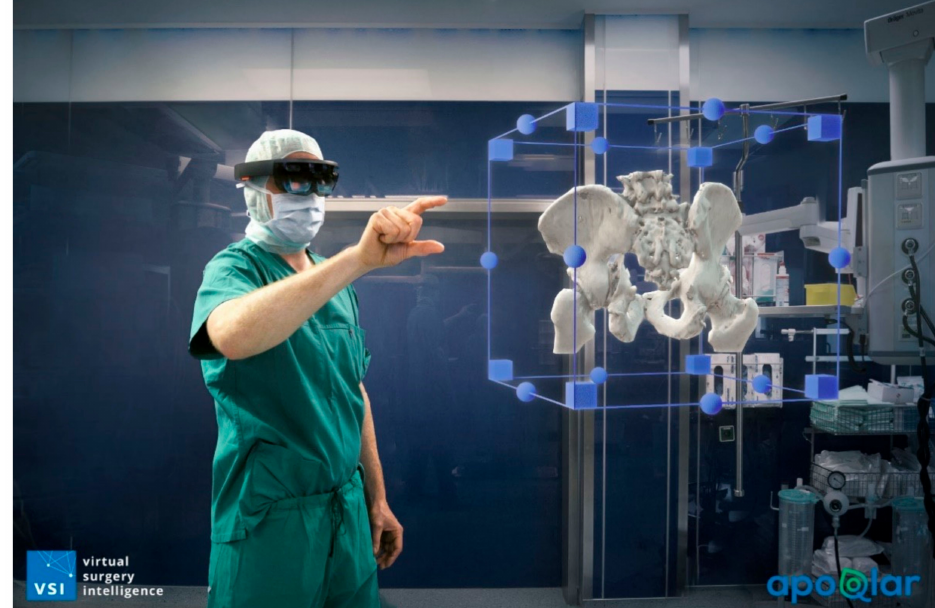
Figure 1. The image indicates how the operator can visualize a part of the patient’s anatomy. If 3D imaging is used as part of case assessment, an operator can be presented with a hologram of the patient’s anatomy that can be manipulated with simple hand gestures.